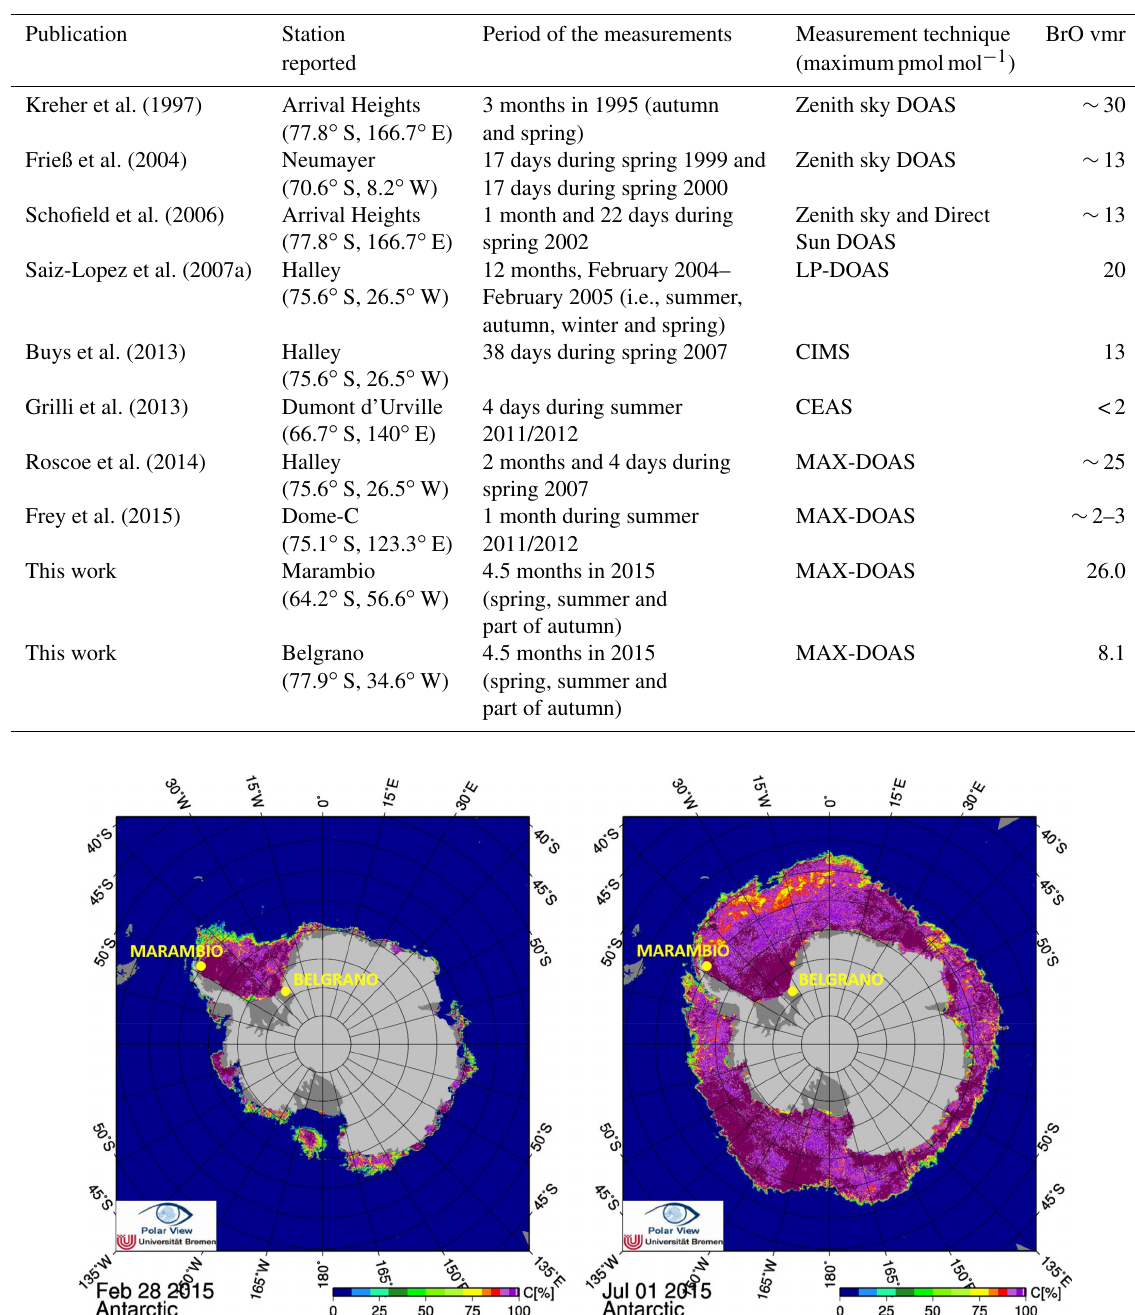
Table 1. Summary of the published ground-based observations of tropospheric BrO made in Antarctica. Published works of tropospheric BrO observations performed from different Antarctic stations. The time periods of the observations, measurement technique used and maximum BrO reported are also included. The “ ∼ ” symbols in the maximum BrO reported correspond to estimated values. For details, please refer to the respective publications.